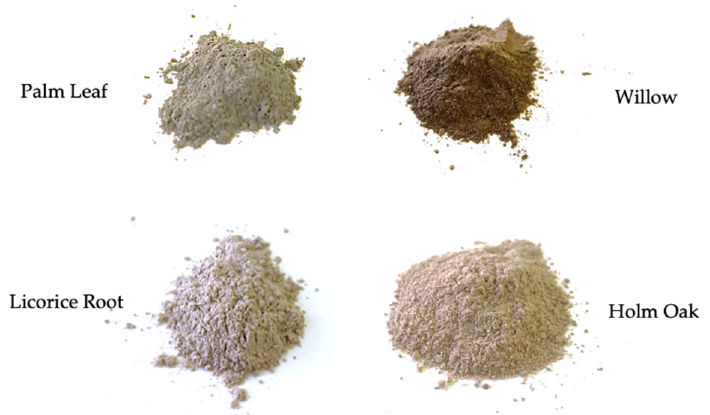
Figure 2. Appearance of ground lignocellulosic fillers.